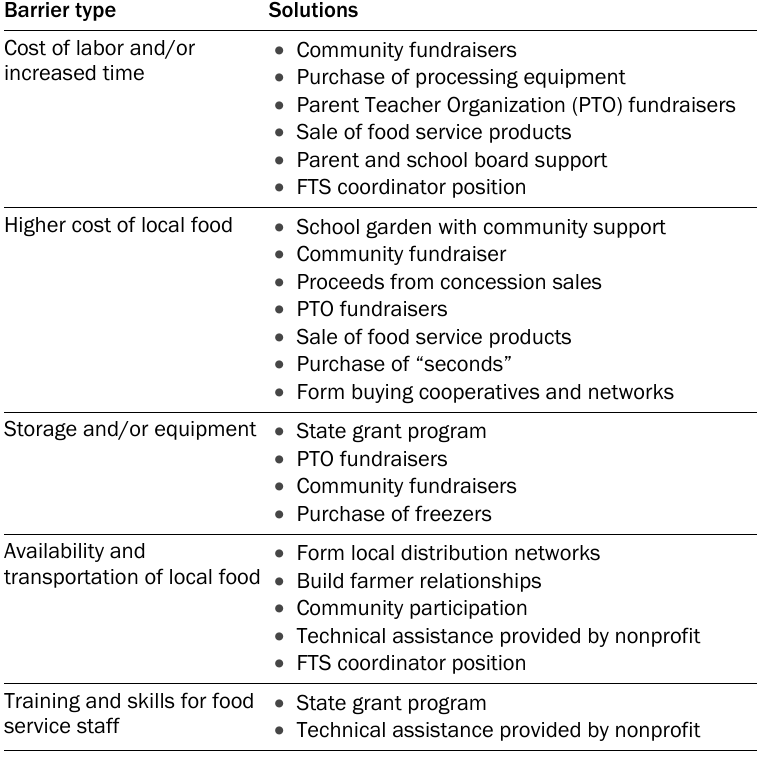
Table 3. Summary of Solutions a Barrier